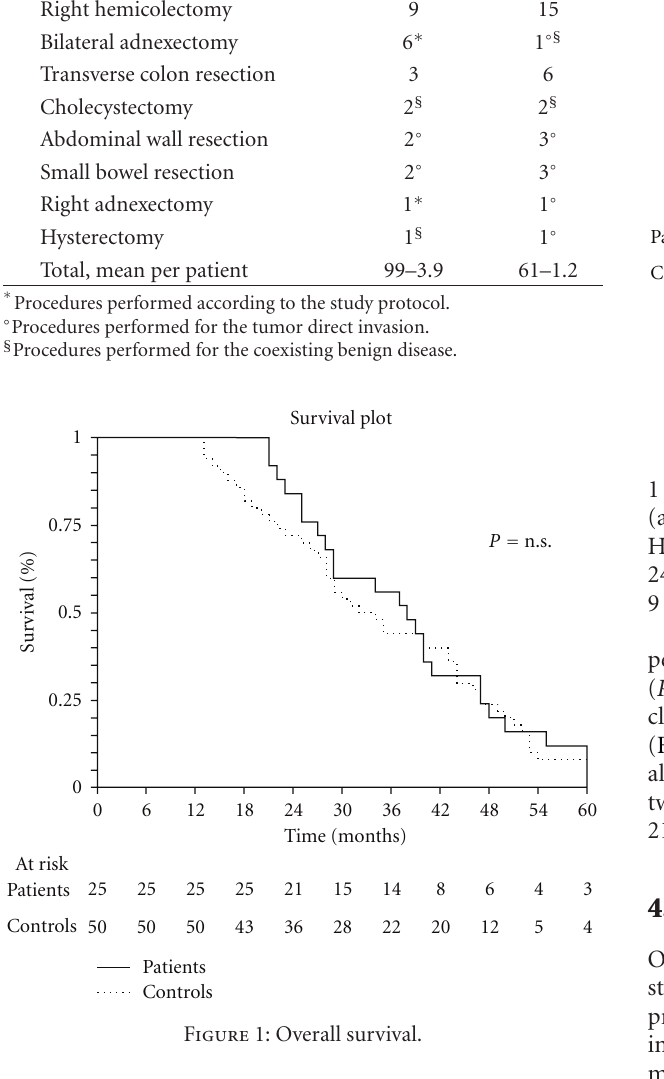
Figure 1: Overall survival.